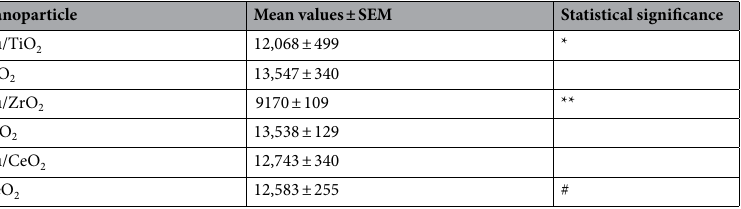
Table 2. Reactive oxygen species (ROS) production in RAW 264.7 cells after expositions to different NPs. The final concentration of NPs was 50 µg ml −1 . Amounts of ROS production were evaluated by the DCFH-DA (n = 7). * p < 0.05 vs TiO 2 , ** p < 0.01 vs ZrO 2 , # p < 0.05 vs TiO 2 and ZrO 2